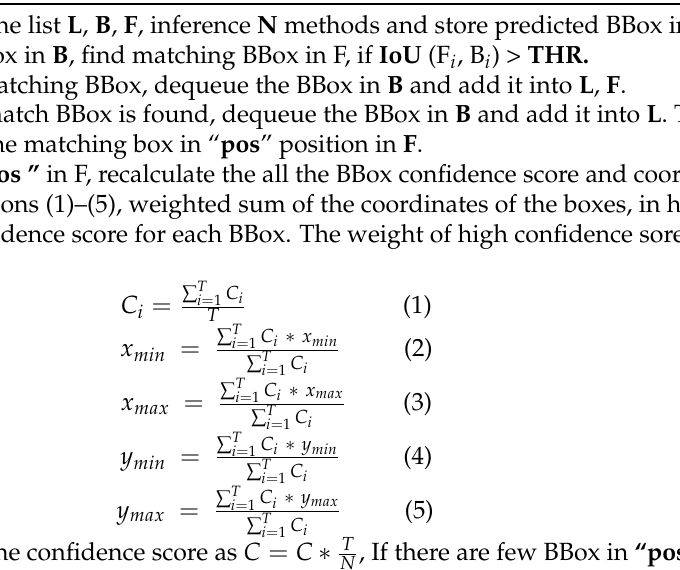
Table 2. Weighted boxes fusion for merging BBox in test time augmentation